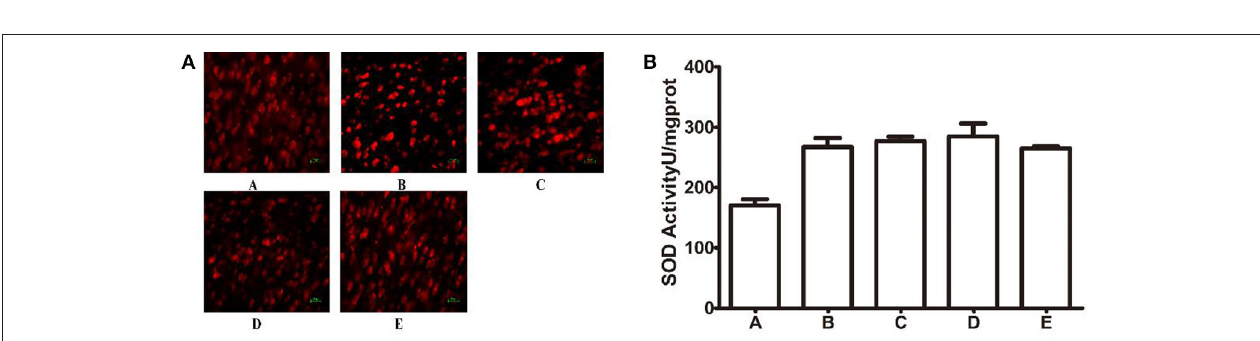
FIGURE 7 | Protein expression of NOX2 and NOX4 in the LHA. (A) Western blots of NOX2, NOX4, and GAPDH in LHA. (B) Quantitative analysis of NOX2, NOX4 expression in the LHA. GAPDH was used as a loading control. *** P < 0.001 (** P < 0.01), as compared with the GI-R group; ### P < 0.001, as compared with the GI-R group; NNN P < 0.001, as compared with the GI-R group. A, Normal group; B, GI-R group; C, FN + GI-R + L -Glu group; D, LHA + GI-R + Baclofen group; E, LHA + GI-R + CGP35348 group. n = 5.